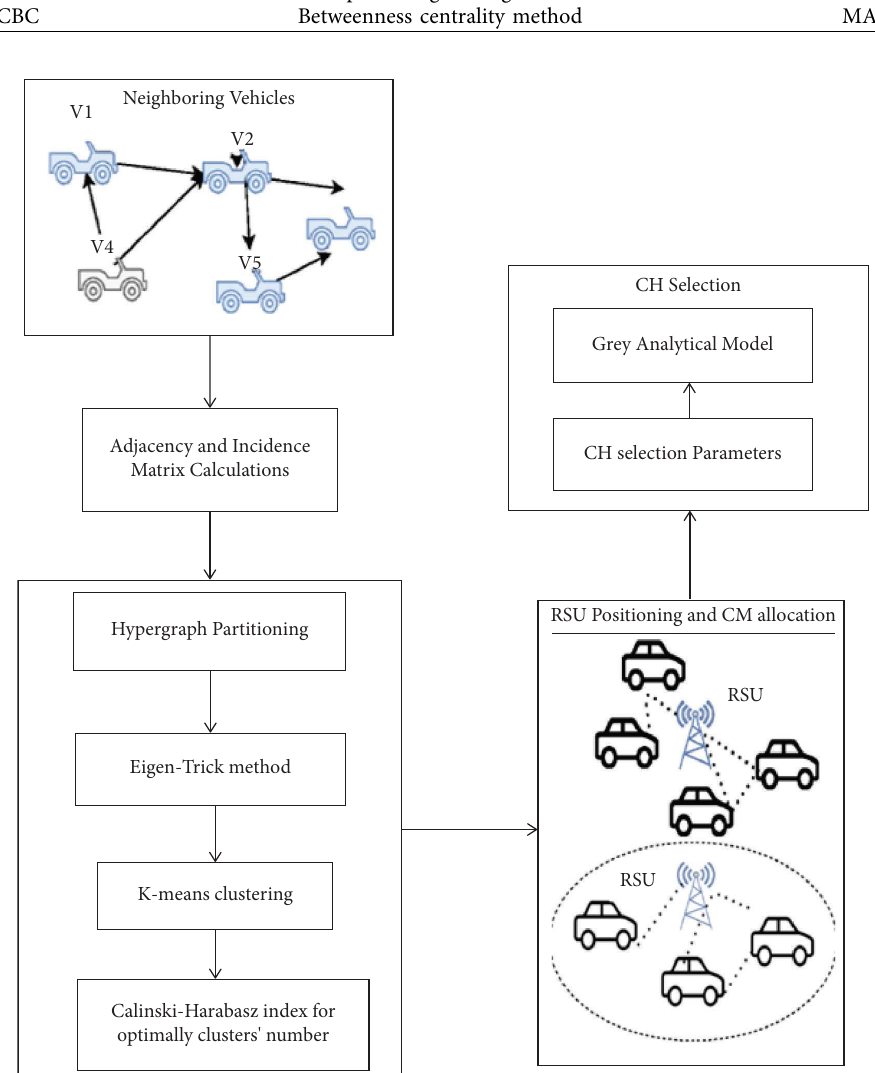
Figure 1: Te EtHgSC fow diagram.